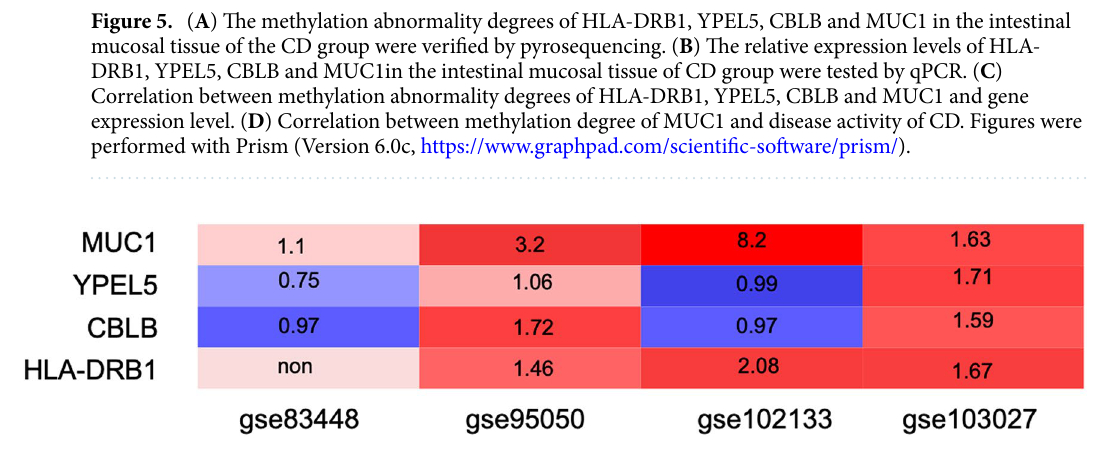
Figure 6. The fold changes of DEGs among GSE95095, GSE83448, GSE103027 and GSE102133. The GEO databases were obtained from NCBI-GEO databases (https:// www. ncbi. nlm. nih. gov/ geo). Figures were performed with affy R package (Version 3.6.1, https:// www.r- proje ct.